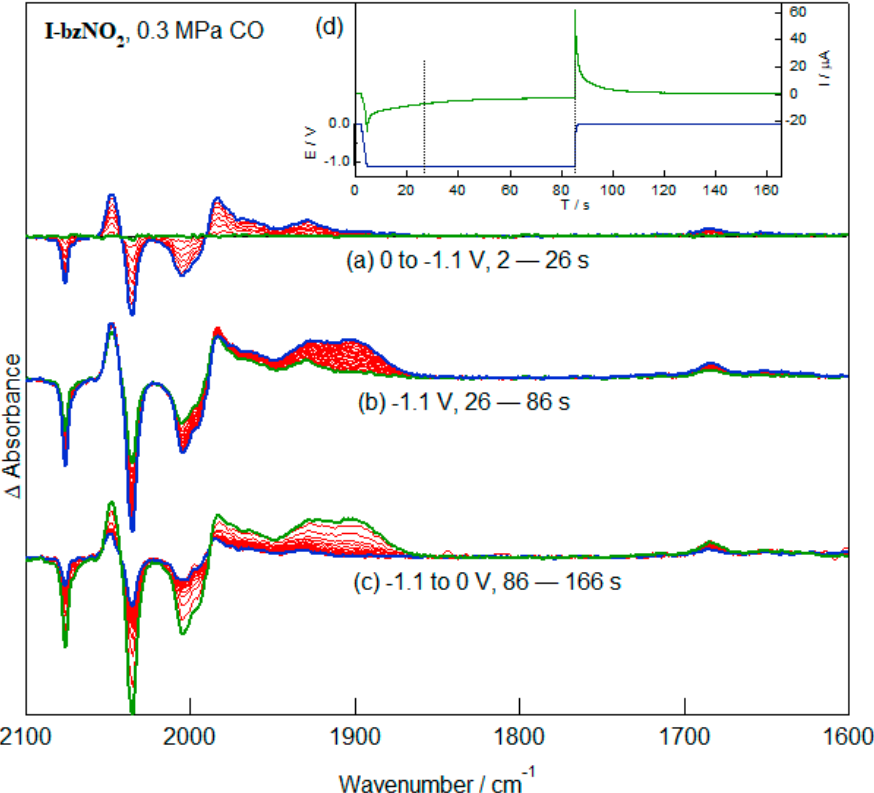
Figure 8. IR-SEC spectra recorded during (a) and (b) the reduction of I-bzNO 2 (2 mM, 0.2 M TBAPF 6 ) in CH 2 Cl 2 saturated with CO (0.3 MPa) and (c) re-oxidation. The time between spectra was 2.68 s.